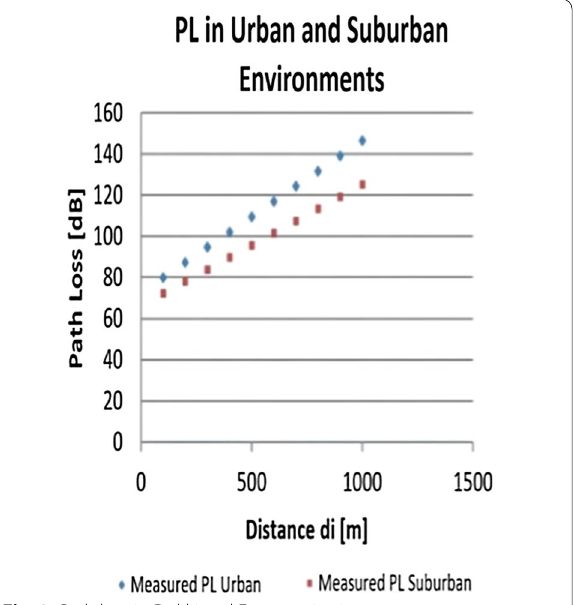
Fig. 3 Path loss in Dokki and Faysa